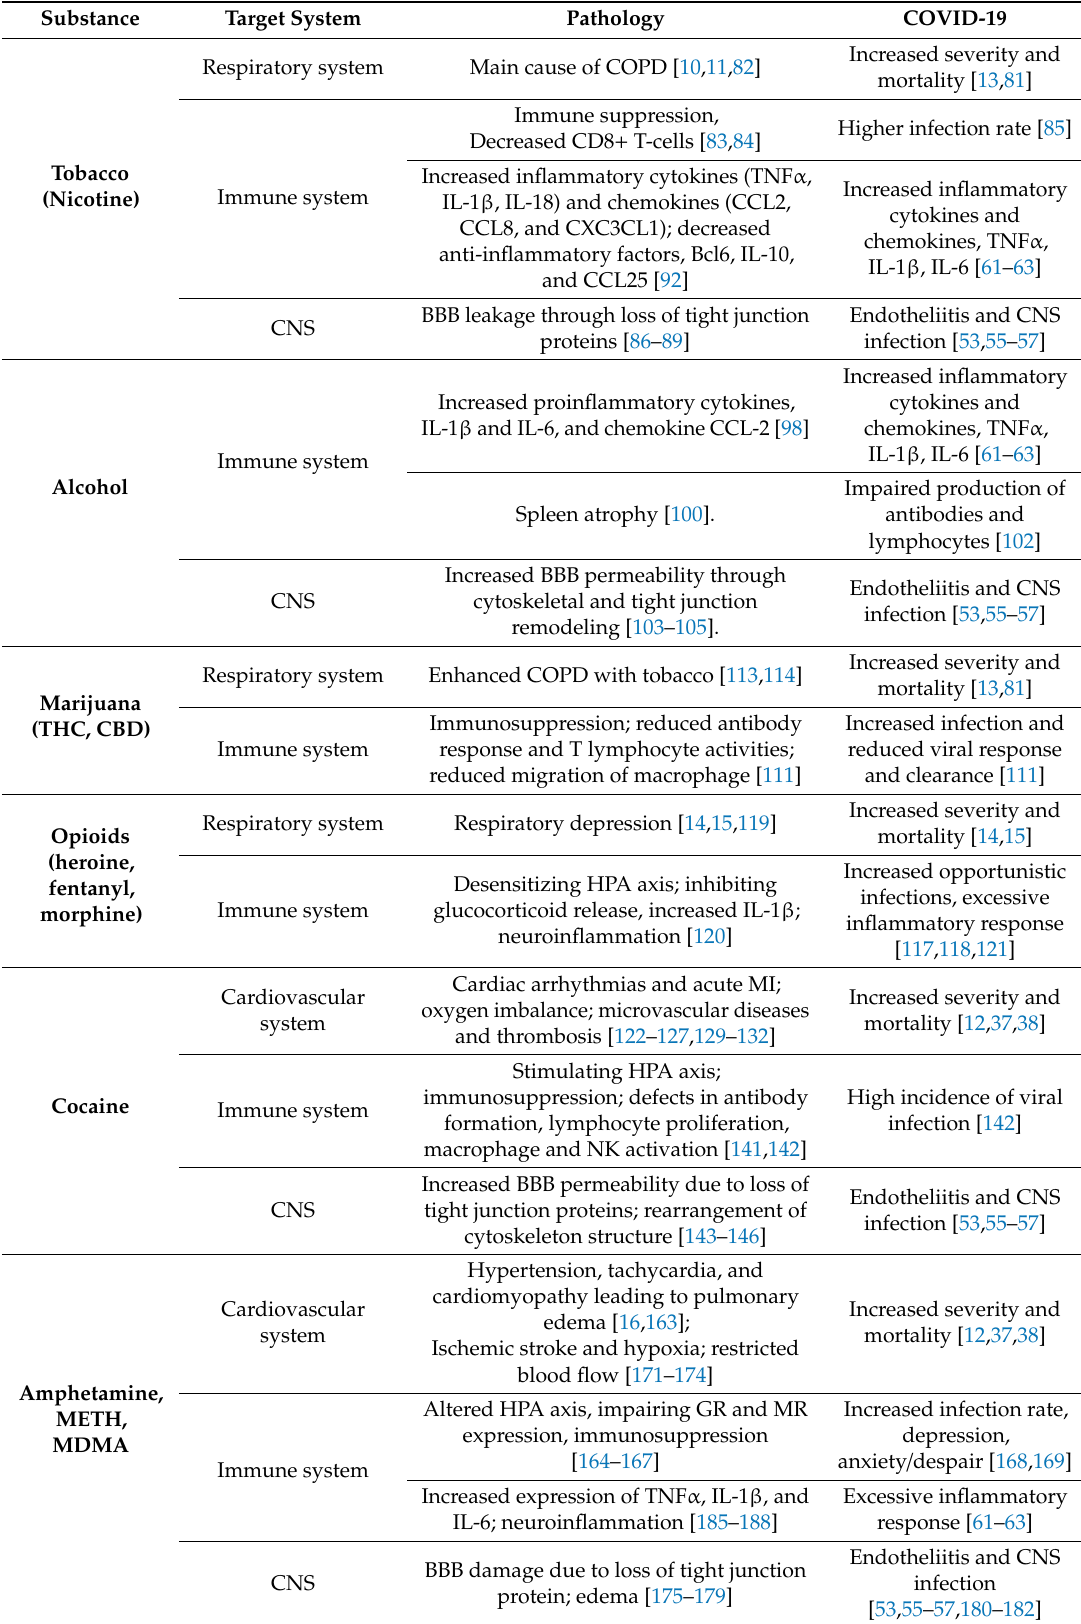
Table 3. Connection of substances of abuse to